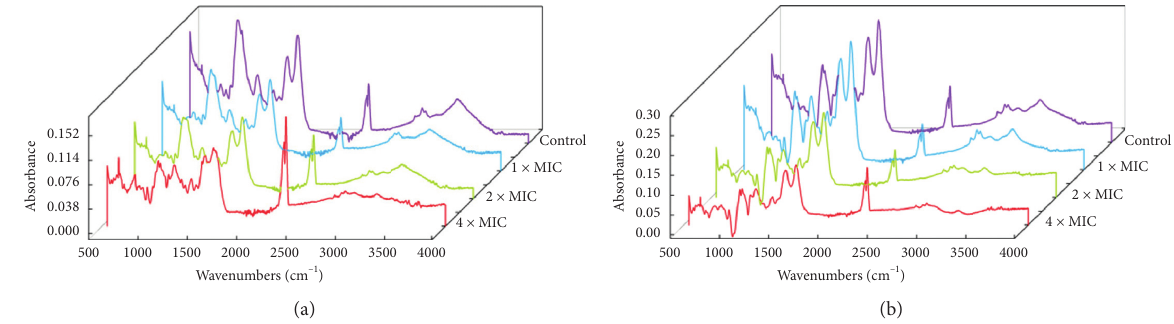
Figure 4: The Fourier transform infrared (FTIR) spectroscopy of P. fluorescens (a) and S. putrefaciens (b) treated with